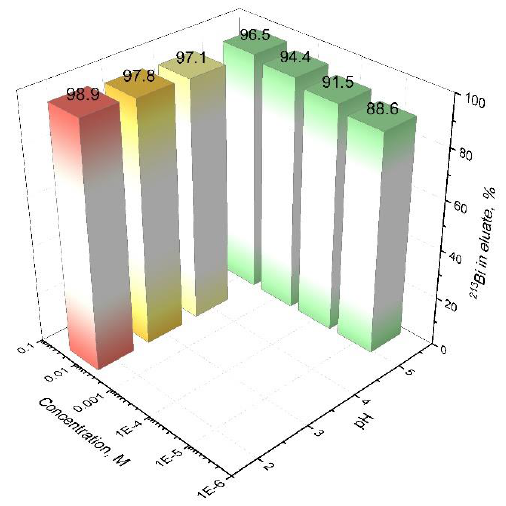
Figure 9. The elution efficiencies of Bi from the column with 0.4 mL AG MP-50 depending on the DTPA concentration and pH of the eluent. The volume of DTPA solution is 5 mL; flow rate—1.0 ± 0.1 mL/min.